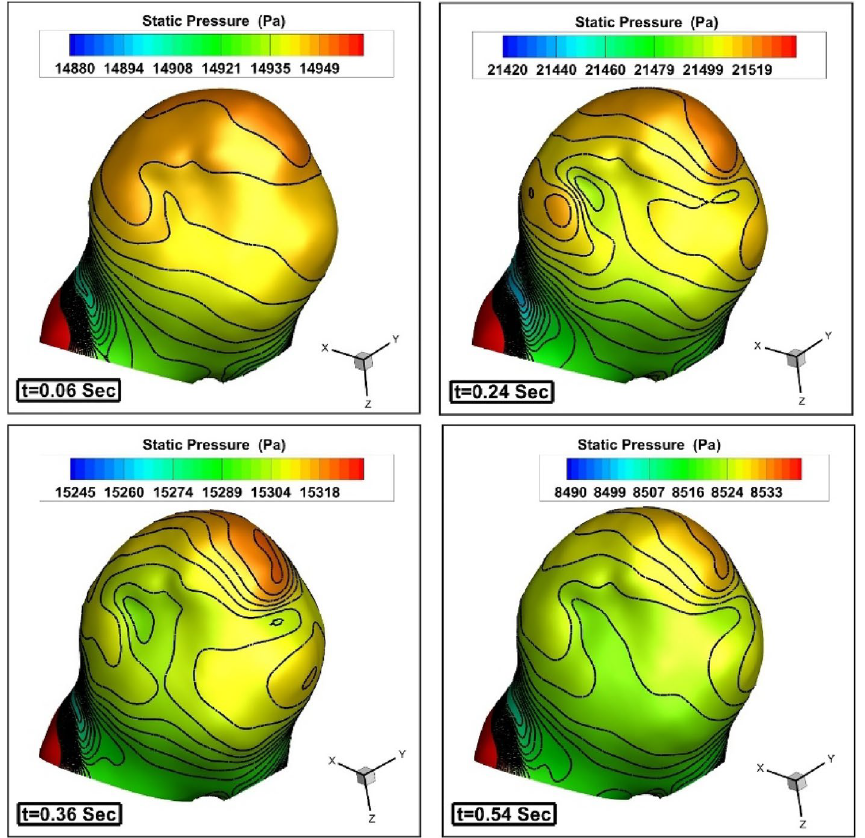
Figure 6. Pressure contour on the sac surface (without